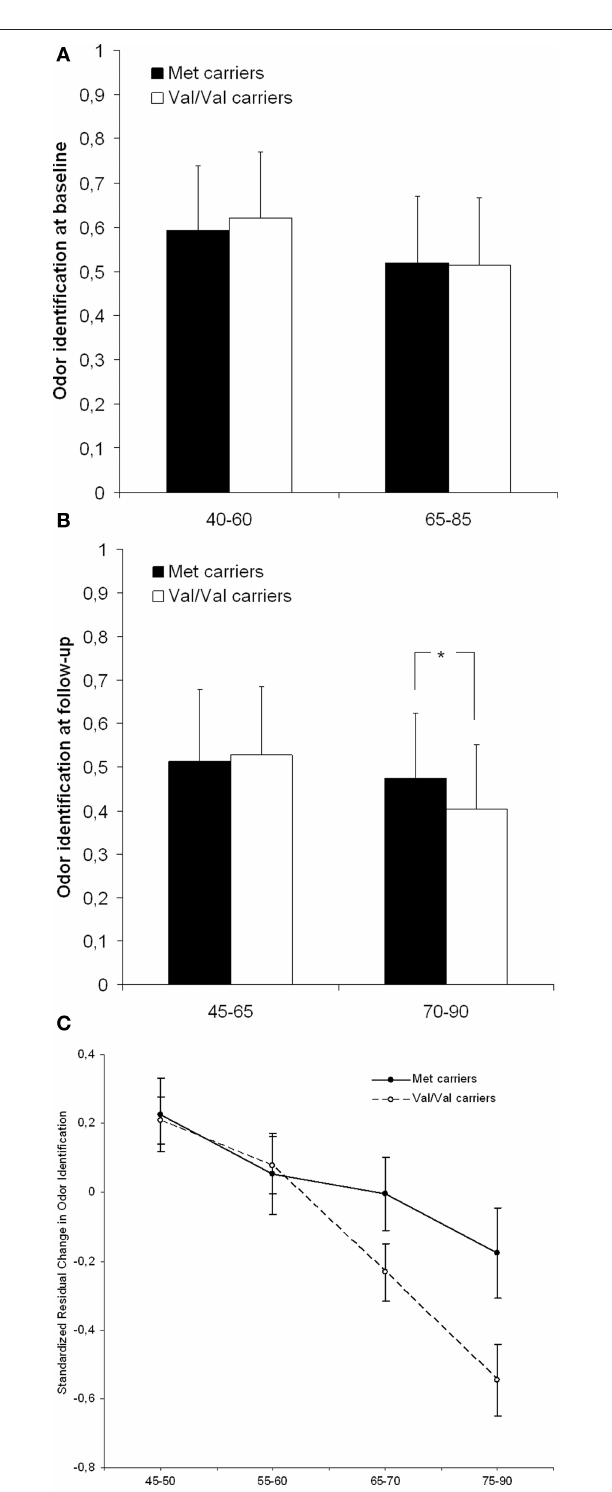
FIgure 1 | Odor identification performance (mean + SD) at baseline testing (A) and at follow-up testing (B) as a function of age and BDNF val66met status. (C) Displays the change in odor identification score (mean ± SE) from baseline to follow-up as a function of age and BDNF val66met